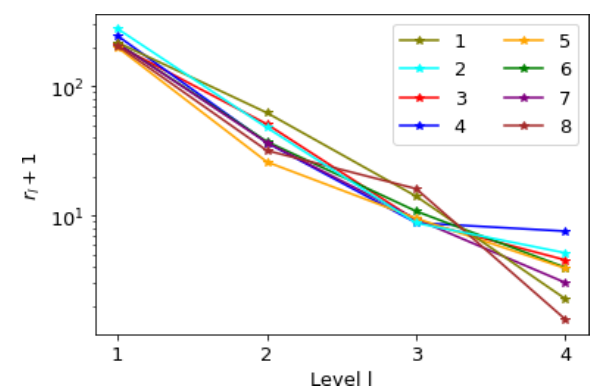
Figure 31. Factor of total LF simulations ( r l + 1) compared to num- ber of HF simulations, where r l is Eq. (13) for the Myrtle Beach test case. Here (cid:15) = 3 × 10 − 3 in Eqs. (14) and (B7) for MLMF and MLMC